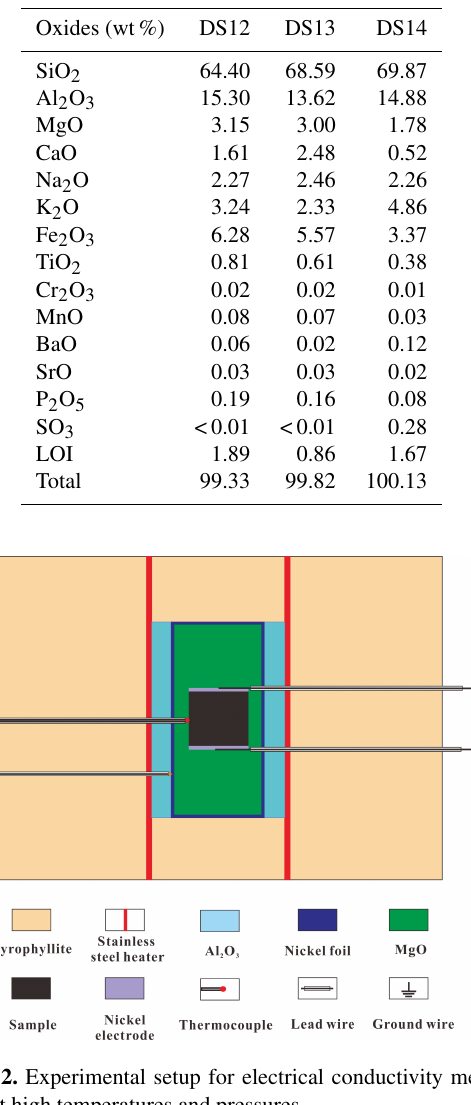
Table 2. Chemical composition of whole rock analysis by X-ray fluorescence (XRF) for three gneiss samples.